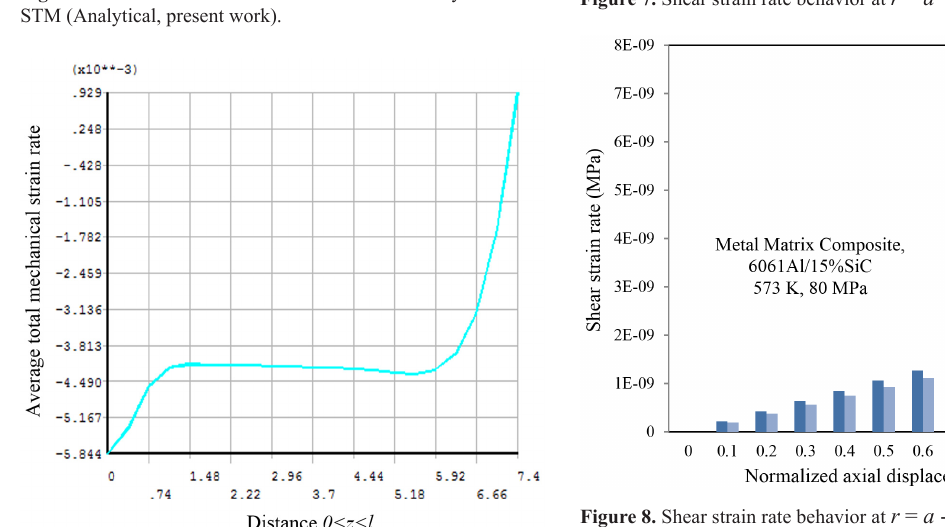
Figure 7. Shear strain rate behavior at r = a + δ .